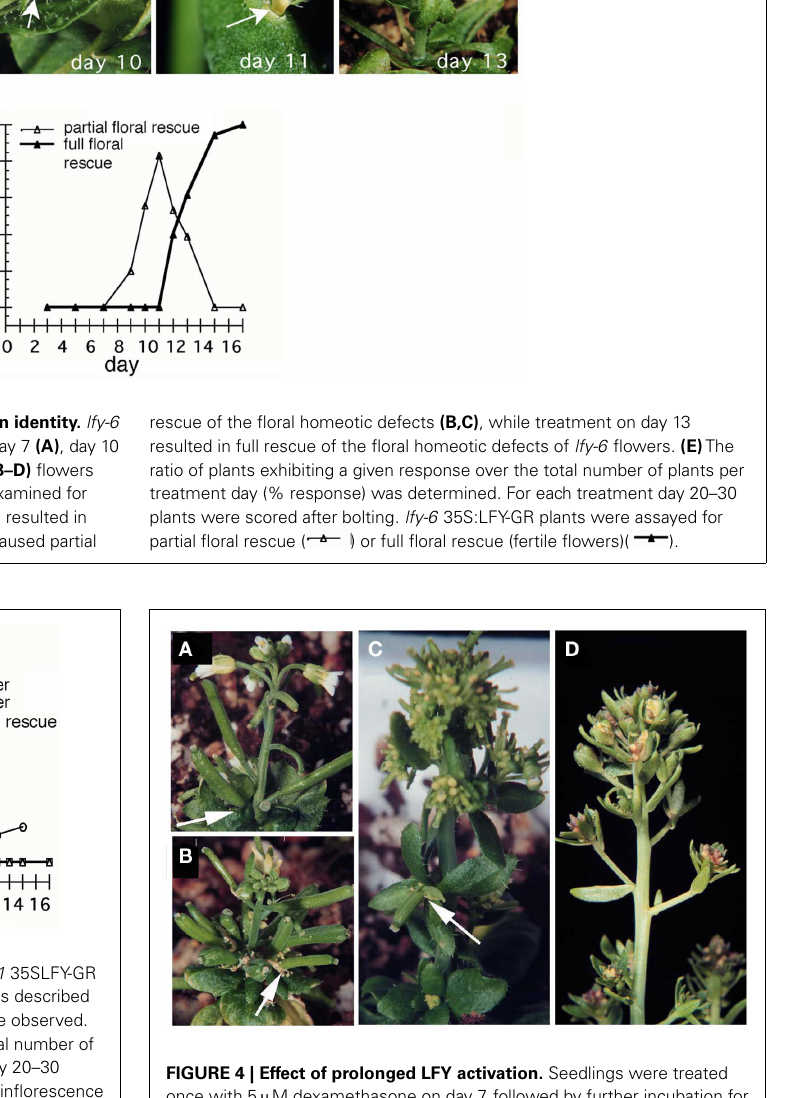
FIGURE 4 | Effect of prolonged LFY activation. Seedlings were treated once with 5 μ M dexamethasone on day 7, followed by further incubation for 4days. Genotypes employed are wild-type (Ler) (A) , lfy-6 (B) , ap1-1 (C) , and ap1-1 lfy-6 (D) .White arrows point to basal secondary inflorescences converted into flowers (A,B) , or a later-arising secondary inflorescence converted into a flower (C) . ap1-1 lfy-6 plants did not respond to this steroid induction (D) .